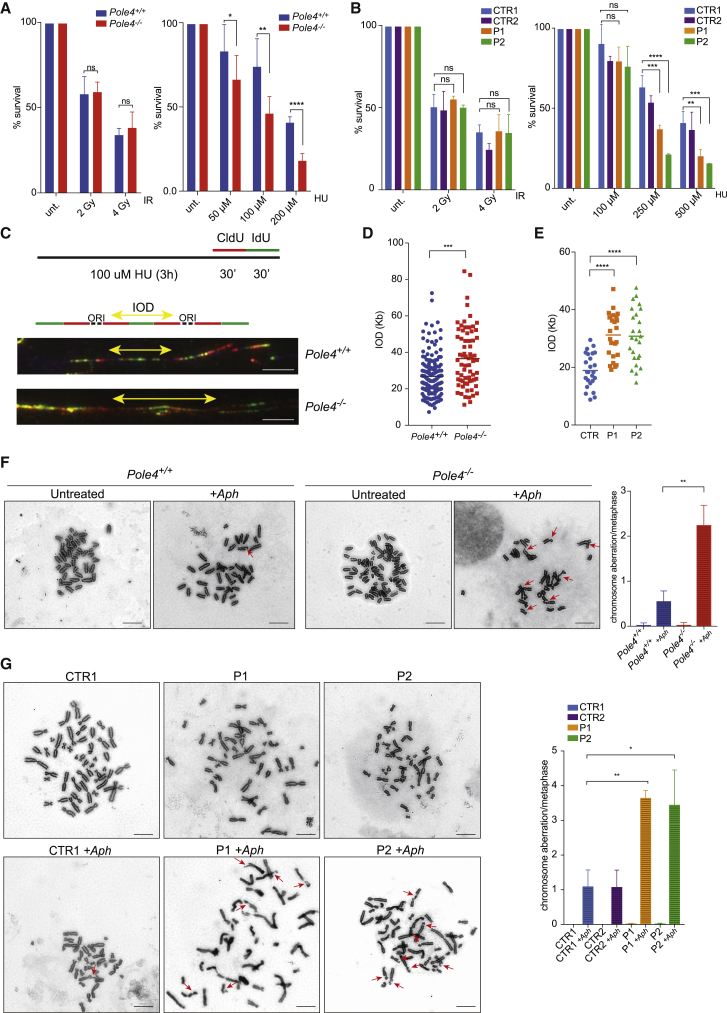
Defective Origin Activation Leads to Chromosomal Instability in Pole4−/− and POLE1 Patient Cells(A) Pole4−/− and Pole4+/+ cells were subjected to IR or HU (hydroxyurea) treatment, with the described doses, and cell viability was assessed after 5 days (ns, not significant; ∗p < 0.05; ∗∗p < 0.01; ∗∗∗∗p < 0.0001); error bars ± SD are included.(B) POLE1 mutant (P1 and P2) and control (CTR1 and CTR2) cells were subjected to IR or HU (hydroxyurea) treatment, with the described doses, and cell viability was assessed after 5 days (ns, not significant; ∗∗p < 0.01; ∗∗∗p < 0.001); error bars ± SD are included.(C) Upper: representative scheme of the hydroxyurea treatment and CldU-IdU labeling scheme used for fiber stretching assay. Lower: representative images of inter-origin distances (IODs) from Pole4+/+ and Pole4−/− cells. Scale bar, 5 μM.(D) Mean inter-origin distance values from HU-treated Pole4+/+ and Pole4−/− MEFs (∗∗∗p < 0.001).(E) Mean inter-origin distance values from HU-treated CTR and POLE1 mutant cells.(F) Representative chromosome spreads from Pole4+/+ or Pole4−/− MEFs treated or not with APH (0.3 μm for 24 hr). Yellow arrows indicate scored chromosomal aberrations such as breaks or radials. Scale bar, 10 μM. Right: bar graph showing the main number of chromosomal abnormalities identified in Pole4+/+ or Pole4−/− MEFs treated or not with APH (∗∗p < 0.01); error bars ± SD are included.(G) Representative chromosome spreads from CTR or POLE1 mutant cells treated or not with APH (0.3 μm for 24 hr). Yellow arrows indicate scored chromosomal aberrations such as breaks or radials. Scale bar, 10 μM. Right: bar graph showing the main number of chromosomal abnormalities identified in the described conditions (∗p < 0.05; ∗∗p < 0.01); error bars ± SD are included.